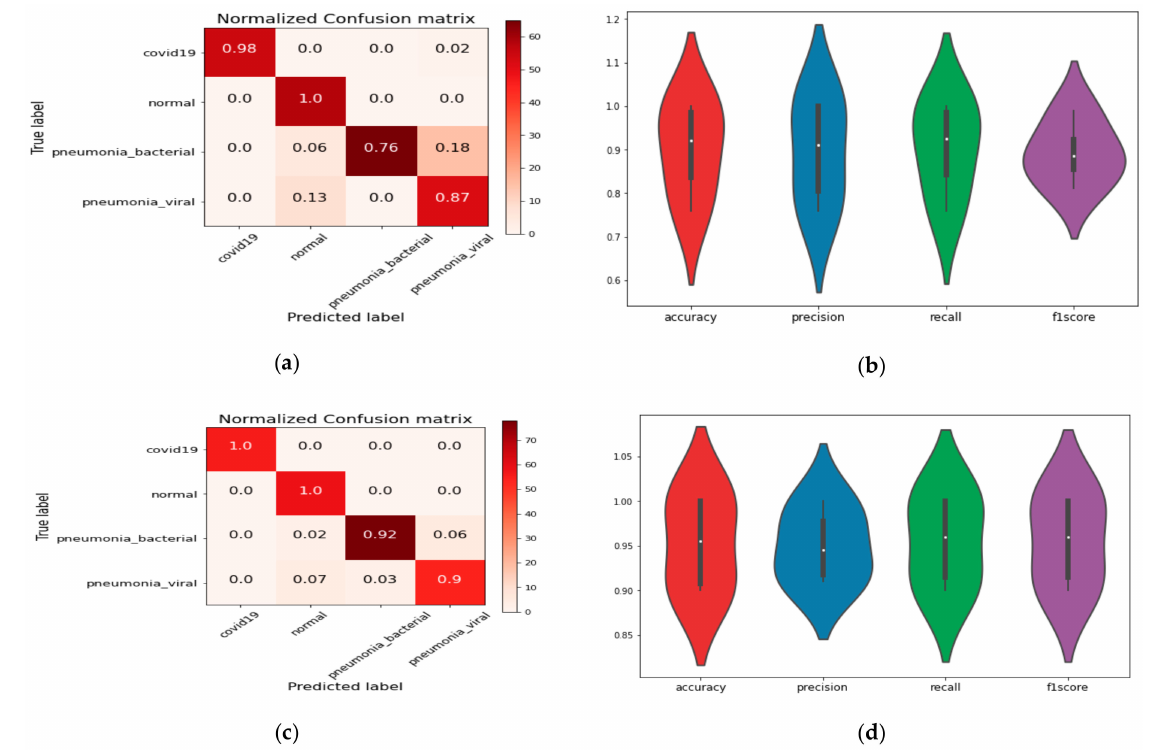
Figure 7. ( a ) The confusion matrix and performance analysis of all classes based on a proposed model with logistic regression (LR) model and ( b ) proposed CoVIRNet model with random forest (RF). ( c ) Performance metrics using logistic regression and ( d ) proposed CoVIRNet model with random